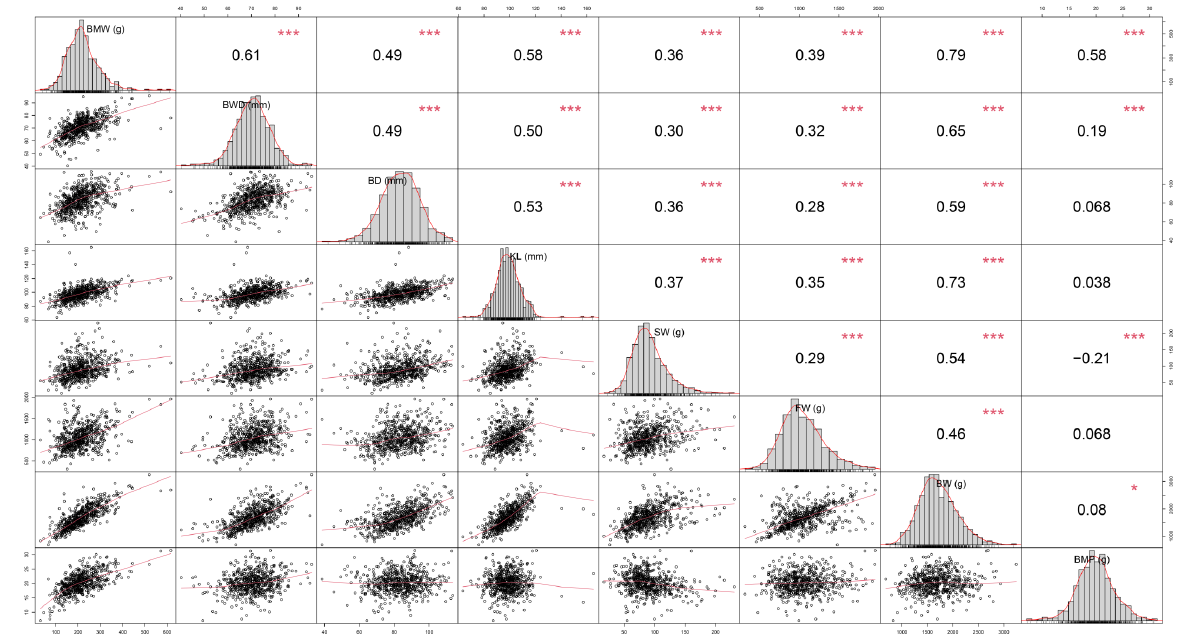
Figure 2. Spearman’s rank correlation coefficient between breast weight and other traits. ( BW ) Body weight (g); ( BMW ) breast muscle weight (g); ( BD ) breast depth (mm); ( BWD ) breast width (mm); ( KL ) keel length (mm); ( SW ) sternum weight (g); ( BMP ) breast muscle percentage (%); and ( H ) full evisceration weight (g); ( FW ) full evisceration weight (g).Statistically significant differences are indicated by * ( p < 0.05), *** ( p < 0.001).